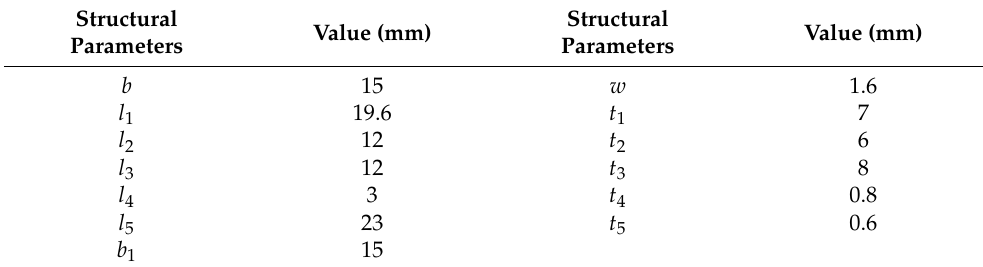
Table 5. The structural parameters of the vertical micro/nano-positioning